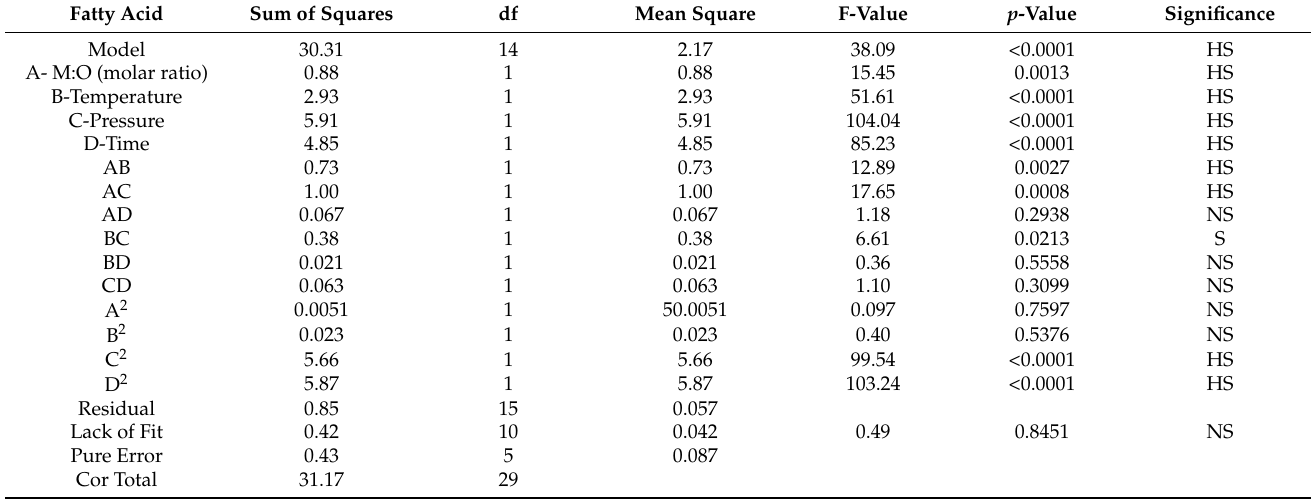
Table A2. Analysis of variance for FAME yield of methyl-palmitate